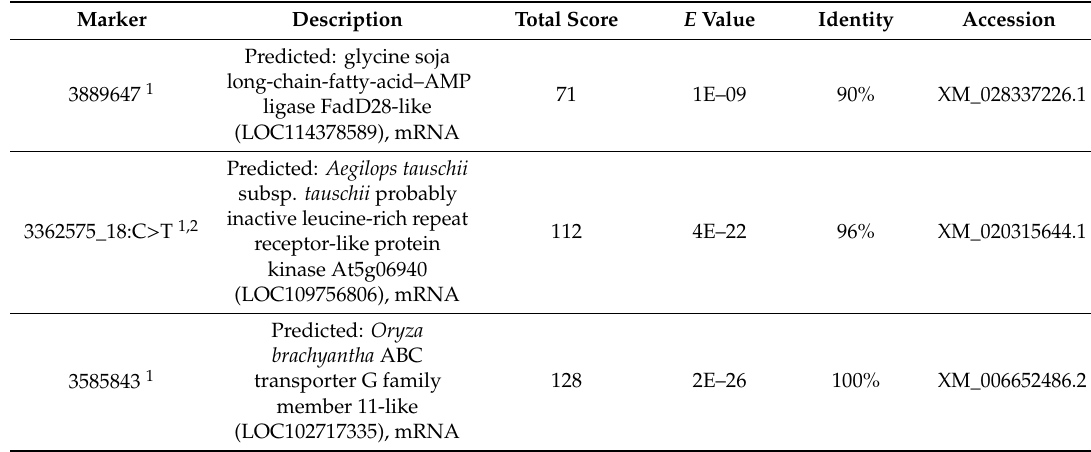
Table 4. Annotations of markers most strongly linked to wax locus ( < 3 cM) found in the NCBI database.